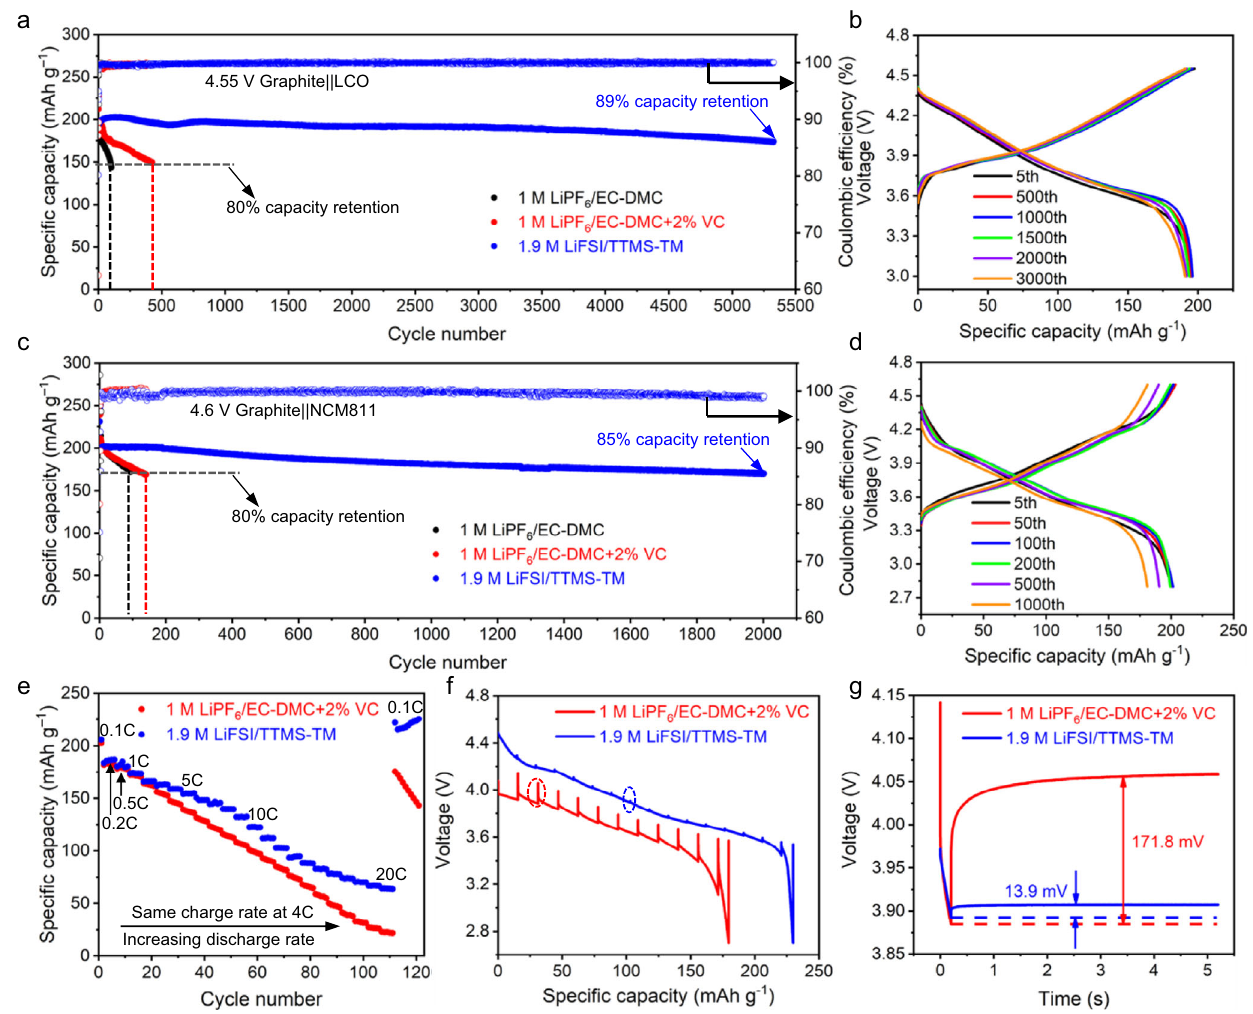
Fig.2|ElectrochemicalperformancesofLi-ionfullcellsusingLCOandNCM811 as cathode materials under high-voltage operation. a Cycling stability of gra- phite||LCO cells at a 4.55V cut-off voltage with 1C charge and 2C discharge rates after three-cycles activation at C/10. b Corresponding charge – discharge curves of graphite||LCO cells using the 1.9M LiFSI/TTMS – TM electrolyte. c Cycling stability of graphite||NCM811 cells at a 4.6V cut-off voltage with 1C charge and 2C dis- charge rates after three-cycles activation at C/10. d Corresponding